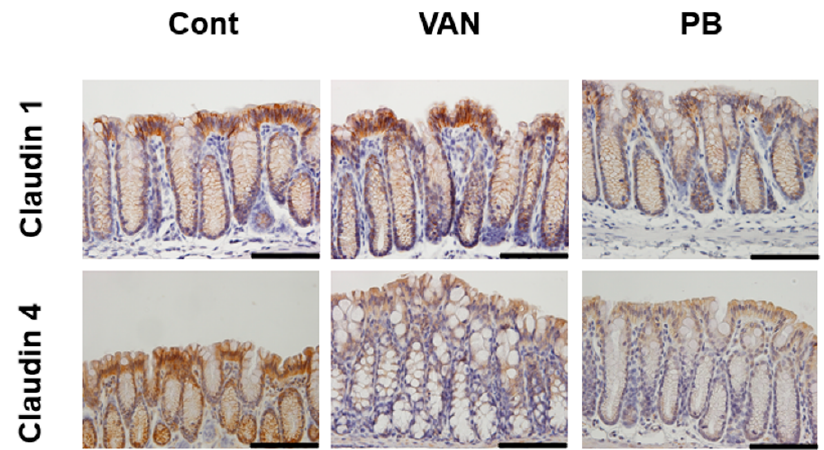
Figure 7. Immunostaining of claudin 1 and claudin 4 in the colonic mucosa of mice treated with vancomycin or polymyxin B. Cont, control; VAN, vancomycin; PB, polymyxin B. Bars = 100 μ m.